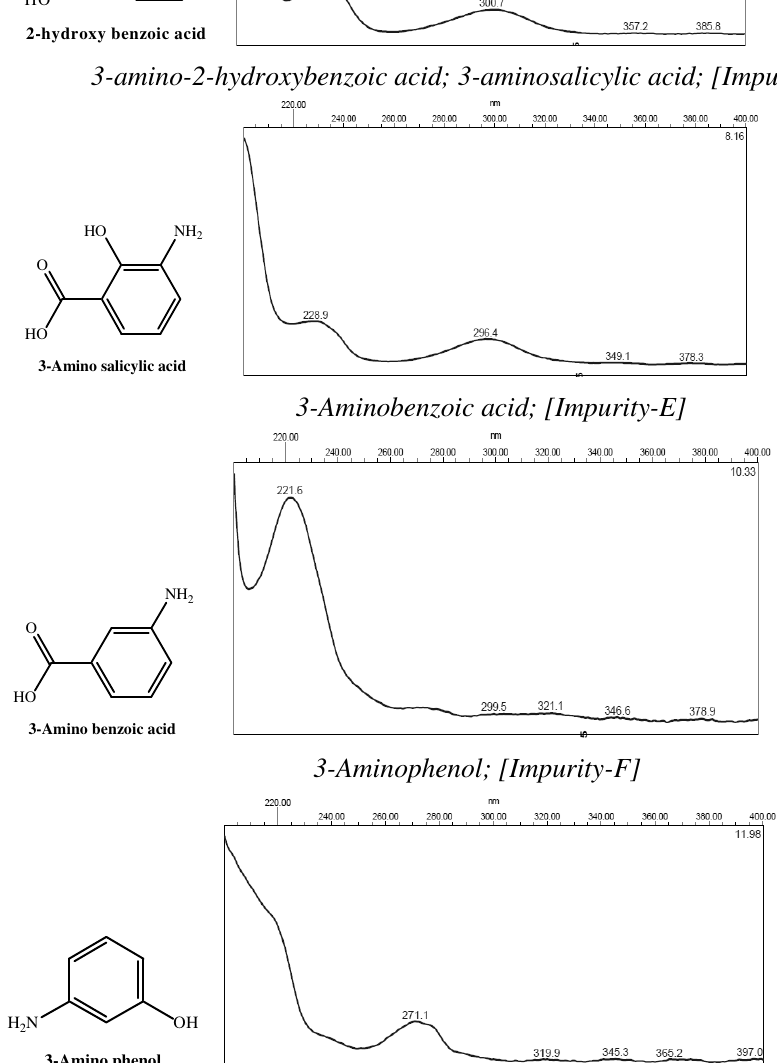
Figure 1. Chemical structures and UV spectrums of mesalamine and its six